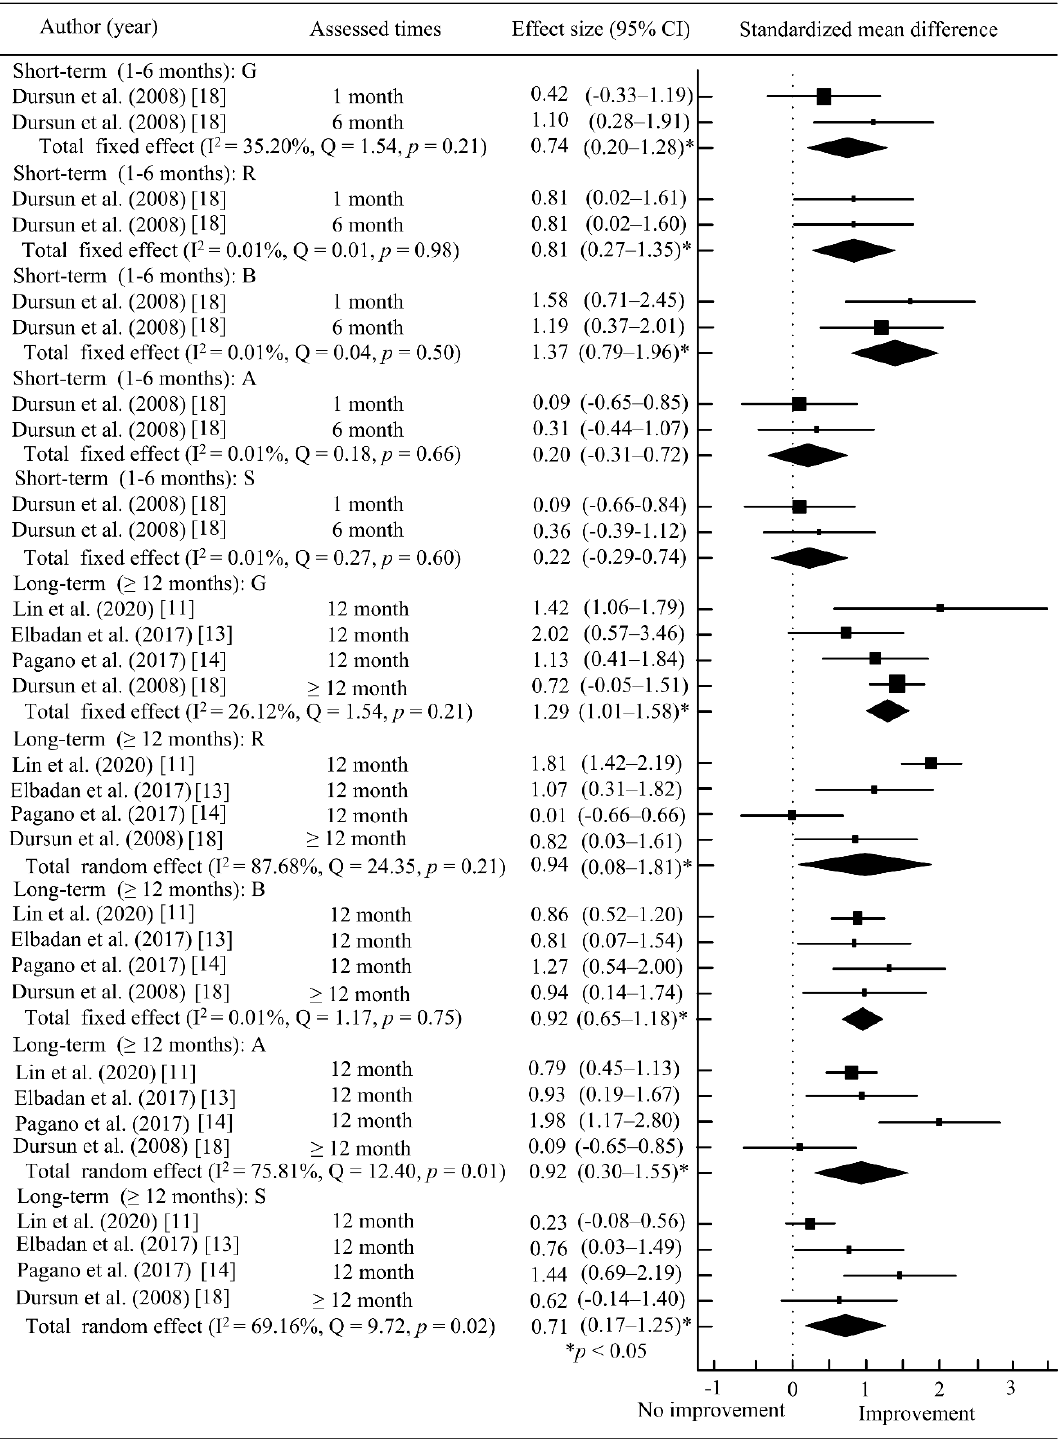
Figure 3. Meta-analysis of GRBAS after AFIL. * p < 0.05; ■, SMD; ◆ total SMD.